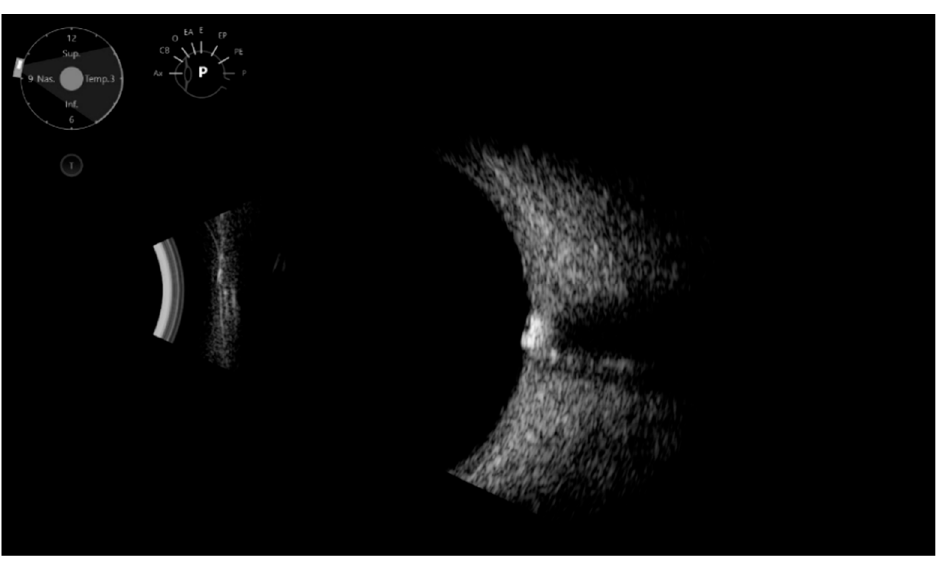
Figure 2. Ultrasound: Point-like optic disc drusen, visible as a highly reflective structure with a small posterior shadowing at the optic nerve level.